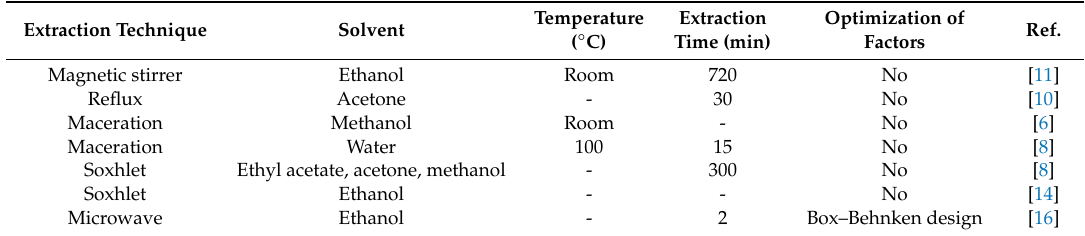
Table 1. The experimental conditions for extraction of phenolic compounds from black locust flowers previously reported in the